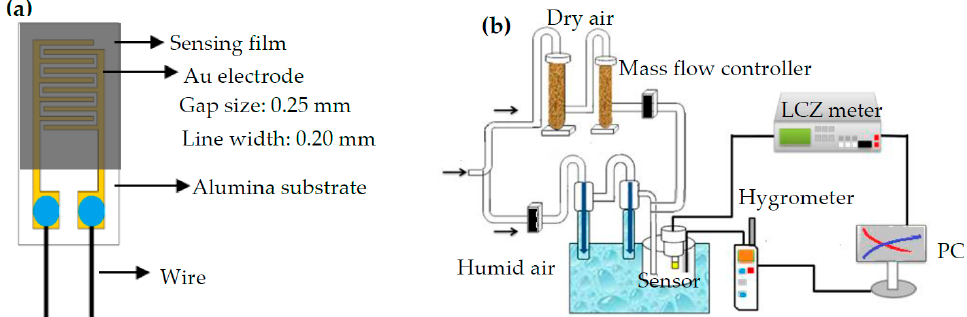
Figure 1. ( a ) Structure of humidity sensor and ( b ) the impedance measurement of humidity sensors and humidity atmosphere controller.